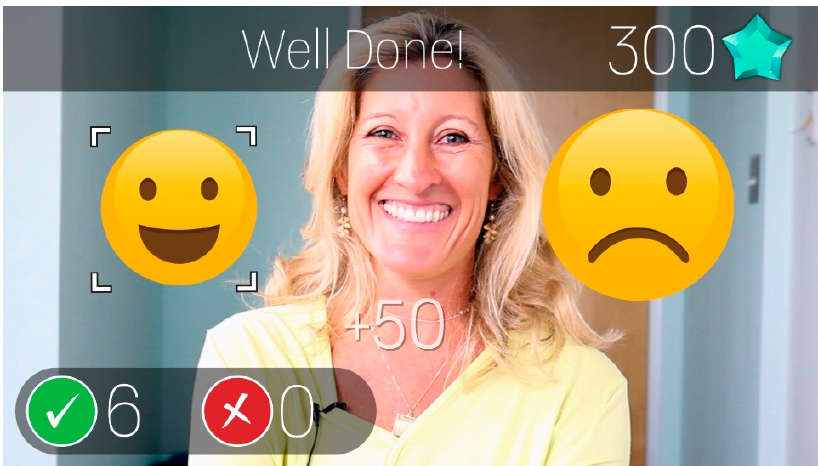
Figure 3. Emotion Charades module . Snapshot of what appears on the smartglasses screen during a representative moment during the Emotion Charades module. The moment depicted is immediately after the user has correctly chosen the “happy” emoticon as the one that represents the emotional expression on the face of the partner. The user gets multi-sensory automated feedback, and additionally the partner is cued to give the user specific prompts and mini-exercises to reinforce increasing levels of processing of the target emotions.